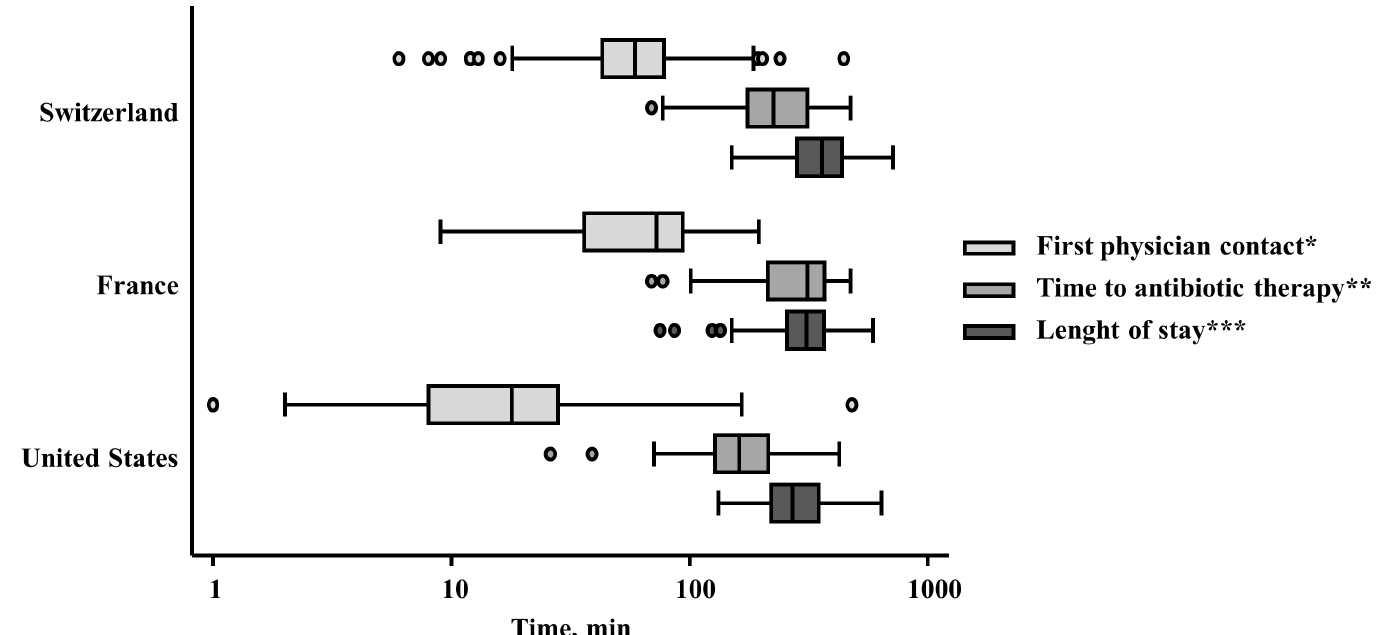
Fig 1. Distribution of ED measures of timely care in patients with acute infections across different countries. The bottom and top of the box represent the 25th and 75th percentiles of the hospital-reported mean times for that measure, with the middle line representing the median. * Time of arrival to time seen by a doctor. ** Time of arrival to time being given medication. *** Time of arrival to time leaving the emergency department for home or for an in- hospital bed.